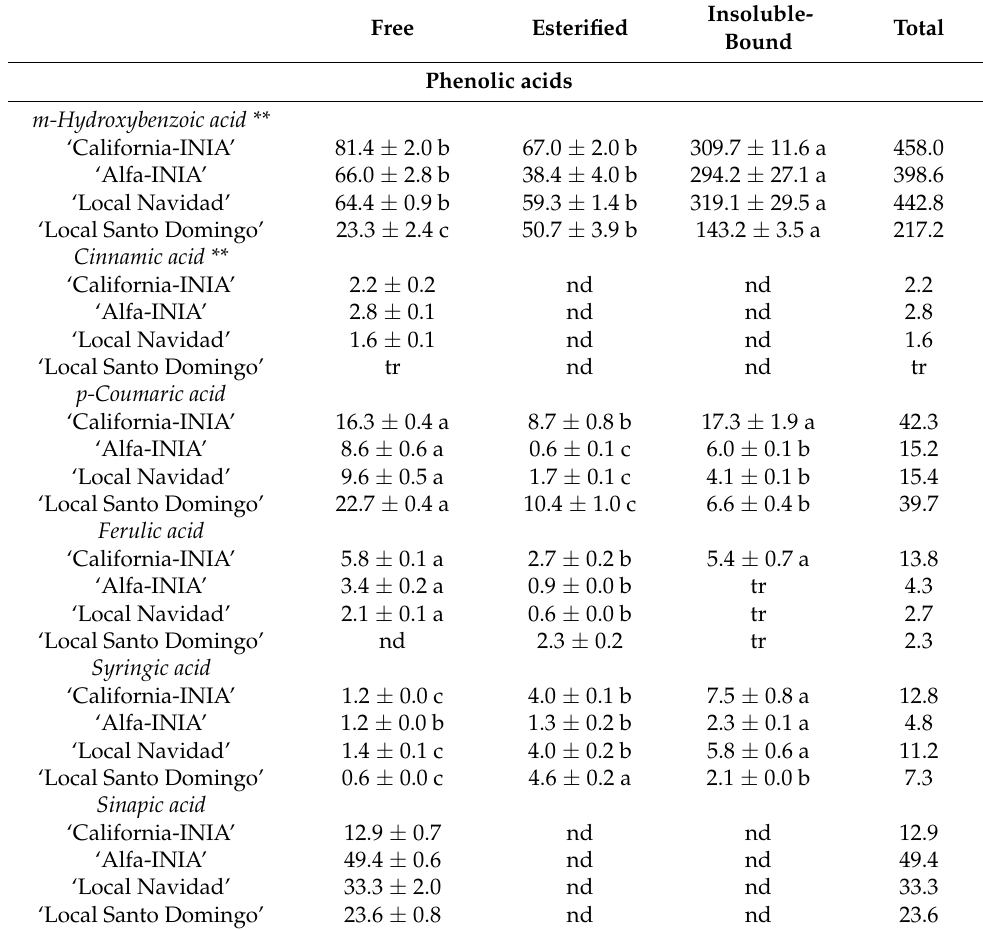
Table 3. Phenolic acids, flavonoids, and isoflavonoids soluble (free and esterified) and insoluble- bound compounds in chickpeas ( µ g/100 g). Free